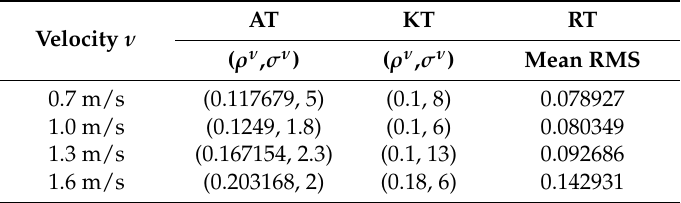
Table 1. The list of thresholds for all velocities when the size of the time window ( w ) is 100. Velocity ν